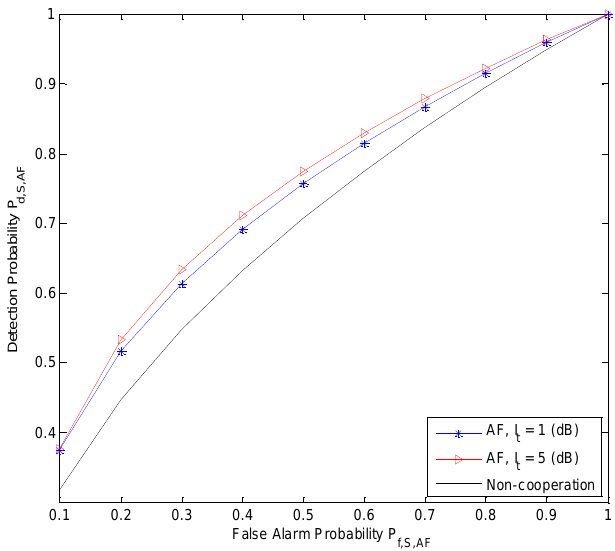
Figure 6. The ROC ( P vs. P ) of the secondary user S in the AF-CSS scheme d,S,AF f,S,AF (P = 3 dB, P = 0 dB, D-Rx S-Rx